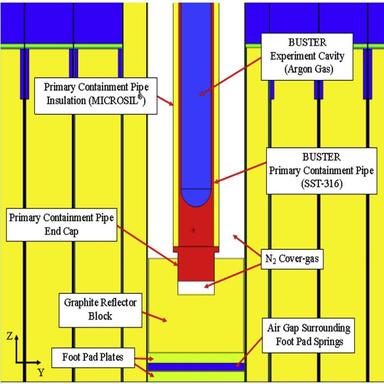
Magnified Vertical View of BUSTER Components in Lower Core Region.